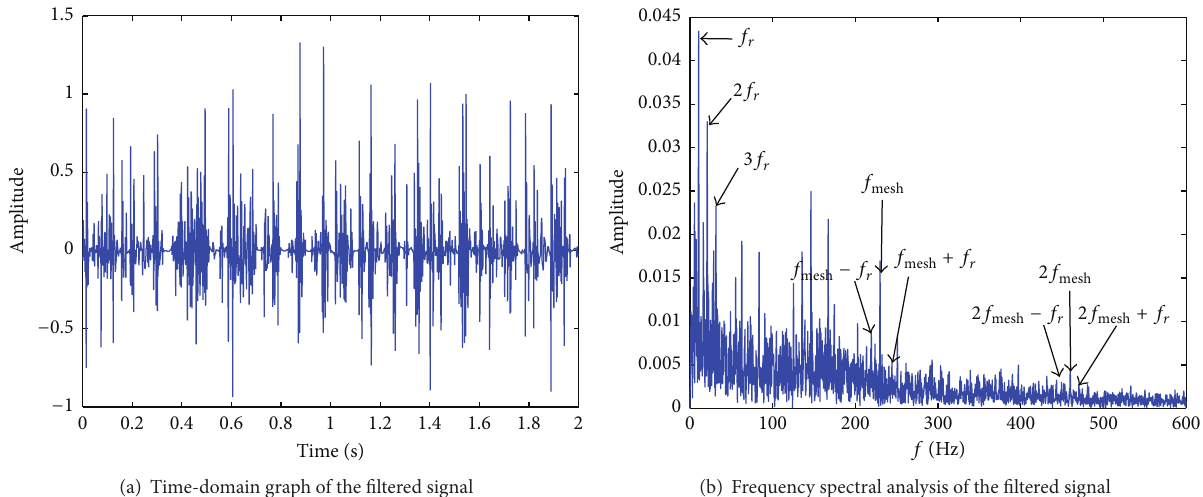
Figure 11: The result obtained by the proposed method (IWATV).